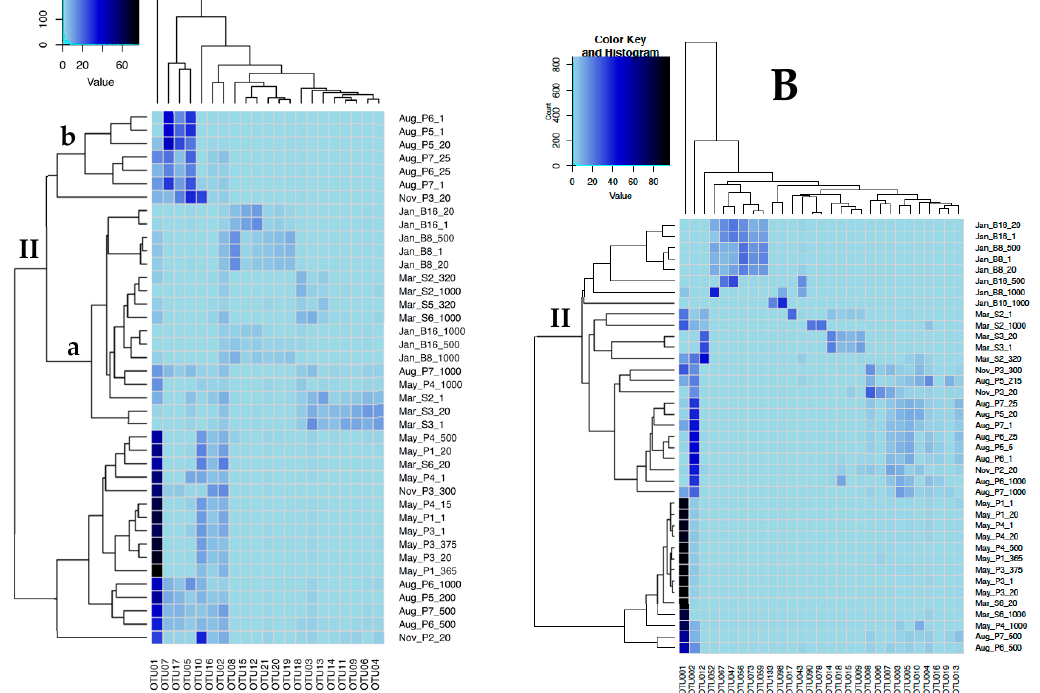
Figure 8. Two-way hierarchical clustering heat maps showing clustering of samples according to similarity in OTU composition. The analyses were based on the relative abundance of dominant OTUs (overall relative abundance >0.1%) in the individual samples. ( A ) g23 and ( B ) mcp genes. The blue shading represents a continuous scale of OTU relative abundance from high (dark blue) to low (light blue).